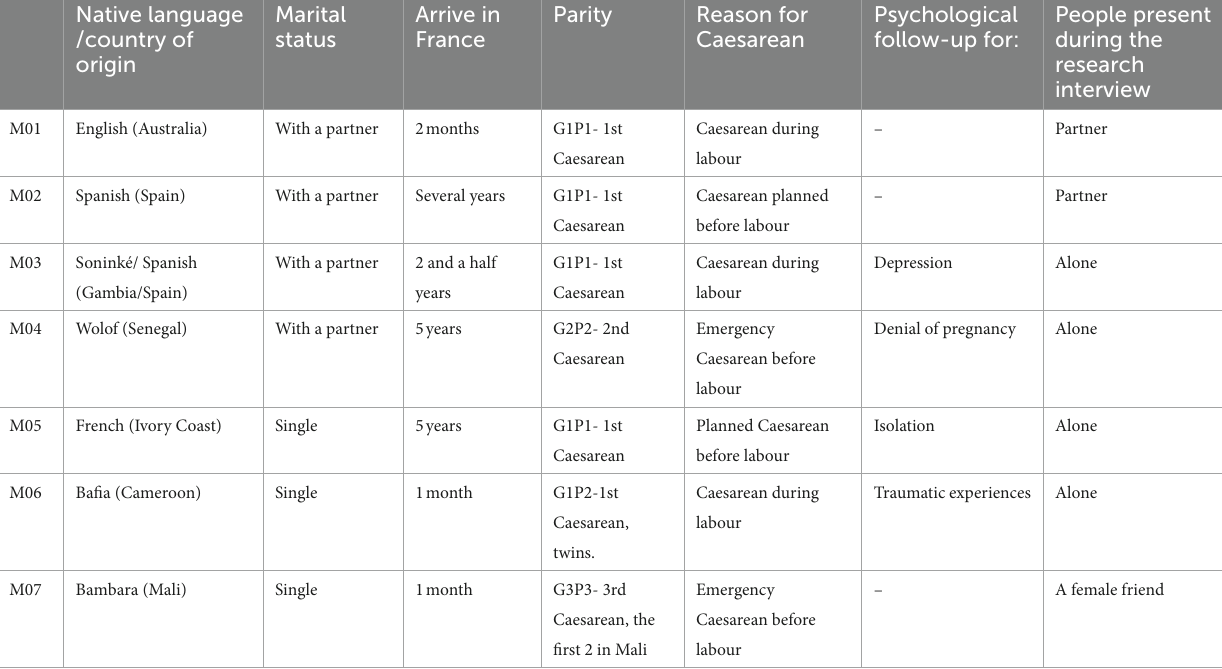
TABLE 2 Participant characteristics. Native language /country